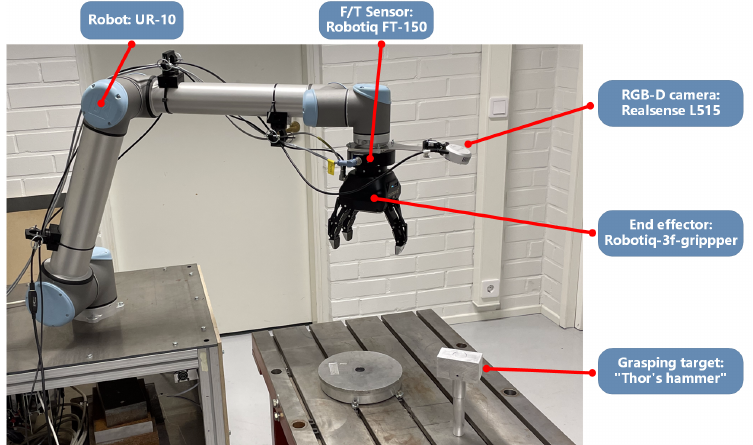
Figure 5. Our experimental